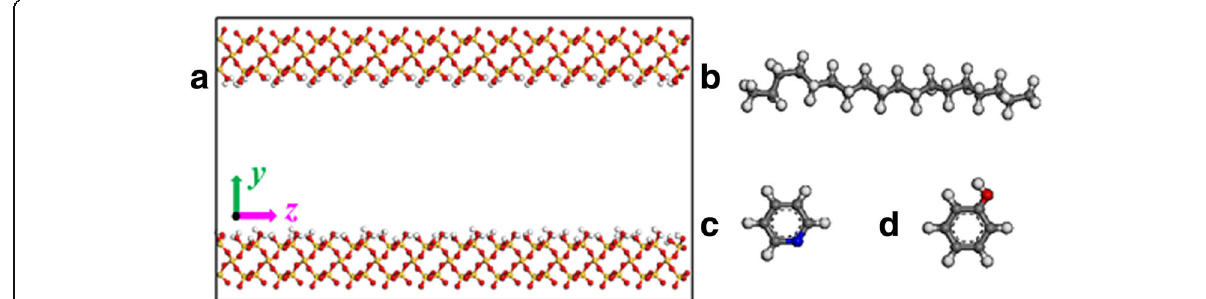
Fig. 1 a Representation of the silica nanochannel model. Molecular structures of b octadecane, c pyridine, and d phenol. Color code for atoms: red , oxygen; white , hydrogen; yellow , silicon; grey , carbon; and blue , nitrogen